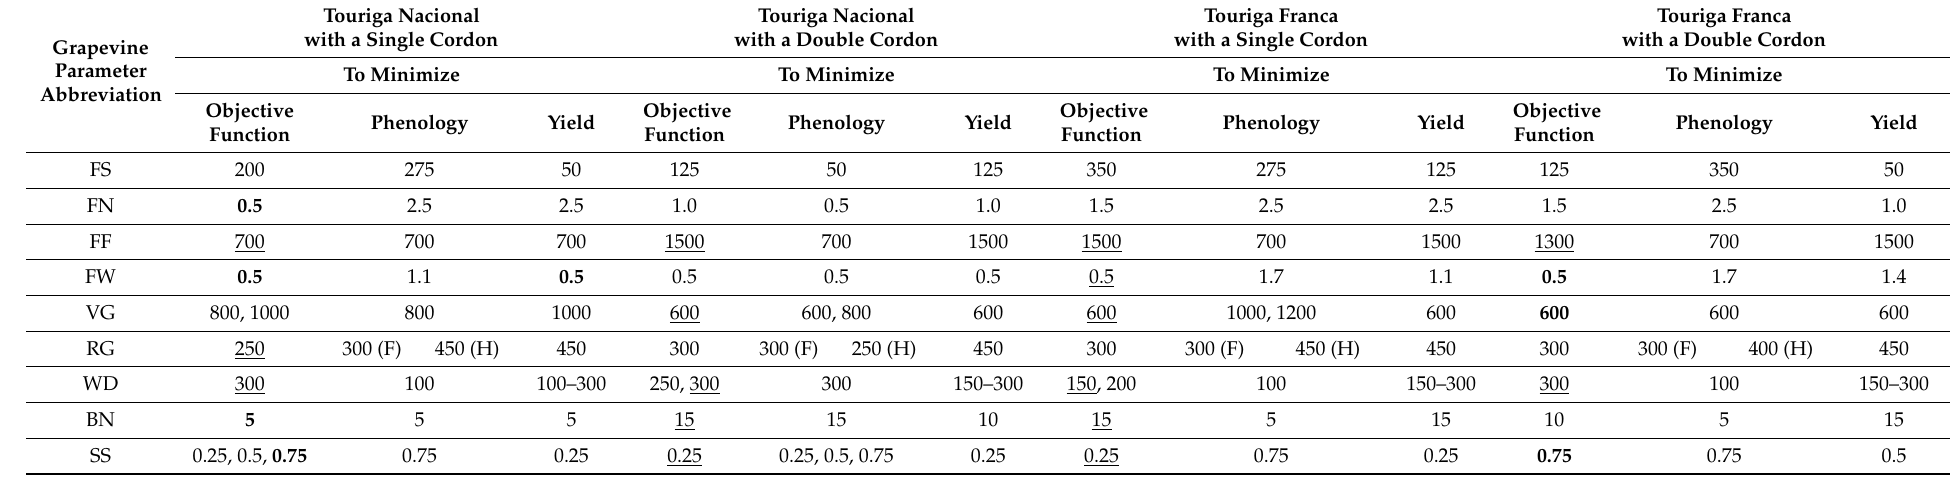
Table 3. List of parameters that respectively minimize the sum of the nRMSE based on the multivariate objective function (combined phenology and yield), and the nRMSE for phenology and yield separately based on the univariate function. Since RG is the only parameter that affects flowering date, a possible difference in values that minimize the nRMSE between the flowering and harvest date is indicated (F: flowering date; H: harvest date). The parameters with the proposed stable calibration are highlighted in bold, whereas the unstable calibrated parameters are underlined (see Section 2.3.4 for